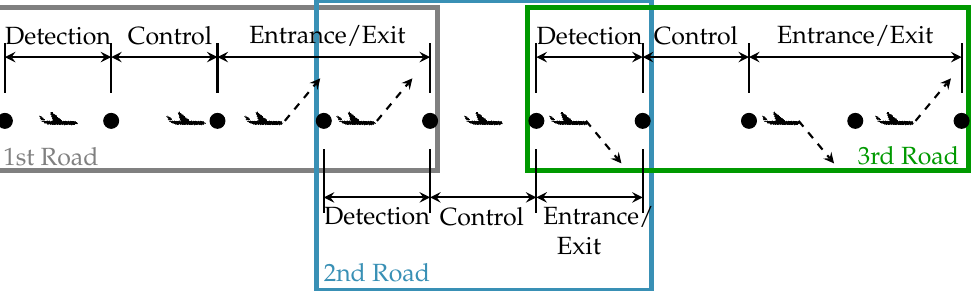
Figure 11. Two entrance/exit sections cannot follow each other. At least one control section must be set between the